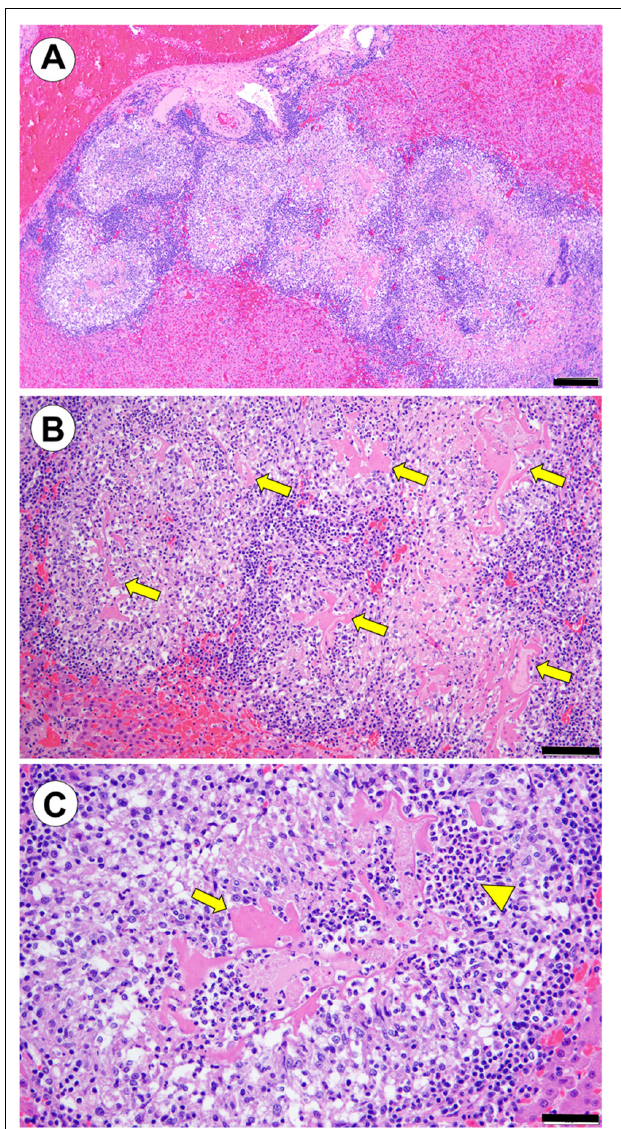
FIGURE 4 | (Case 4): Probable hepatic metazoan parasite migration tracks with intralesional degenerating metazoan cuticle. (A) Linear to serpiginous tracts of necrosuppurative hepatitis, mild tissue cavitation and granulomatous inflammation in the subcapsular hepatic parenchyma (putative parasite migration tracks) (hematoxylin and eosin stain. Bar = 200 µ m). (B) Higher magnification view of affected liver. Multifocal discontinuous, linear to round fragments of eosinophilic hyaline, variably striated material (putative degenerating metazoan parasite cuticle) are visible at the center of some lesions (arrows) (hematoxylin and eosin stain. Bar = 100 µ m). (C) In this high magnification view of a single inflammatory nodule, putative fragments of metazoan cuticle (arrow) are surrounded by dense clusters of eosinophils (arrowhead), and an outer rim of granulomatous inflammation (hematoxylin and eosin stain. Bar = 50 µ